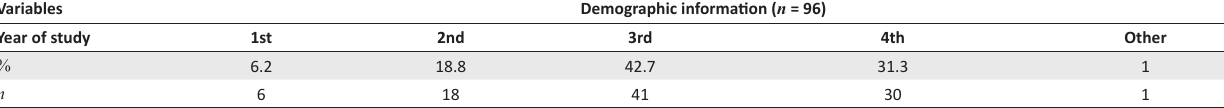
TABLE 1c: Summary of the demographic information of the participants. Variables